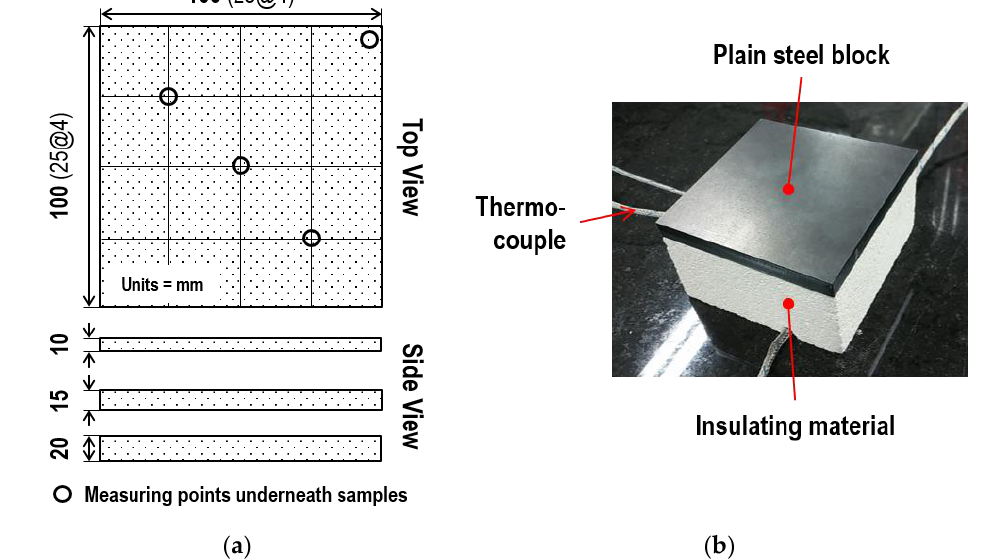
Figure 6. Specimen dimensions ( a ) and photographic view of specimen setup ( b ). Coatings 2019 , 9 , x FOR PEER REVIEW